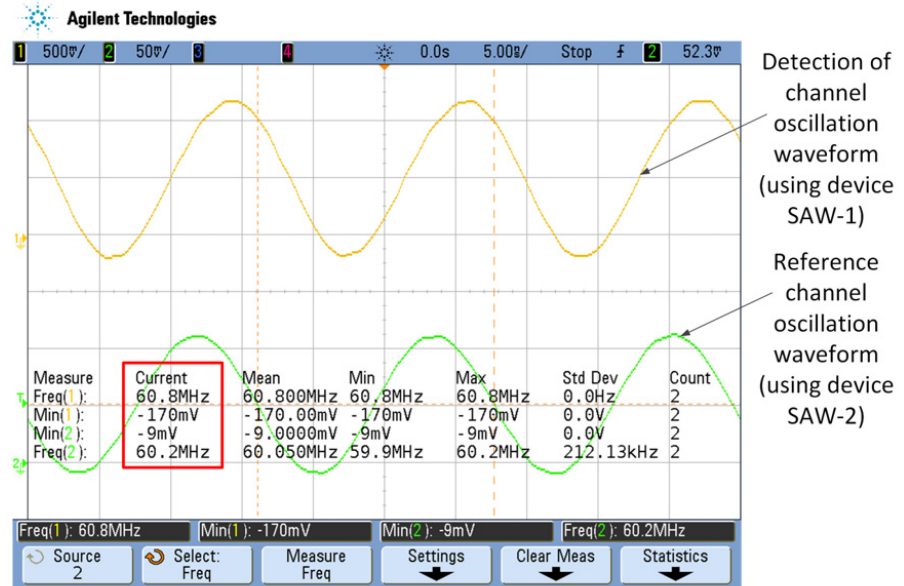
Figure 8. Test waveform diagram of the surface acoustic wave oscillator after adjusting the capacitor Cx .